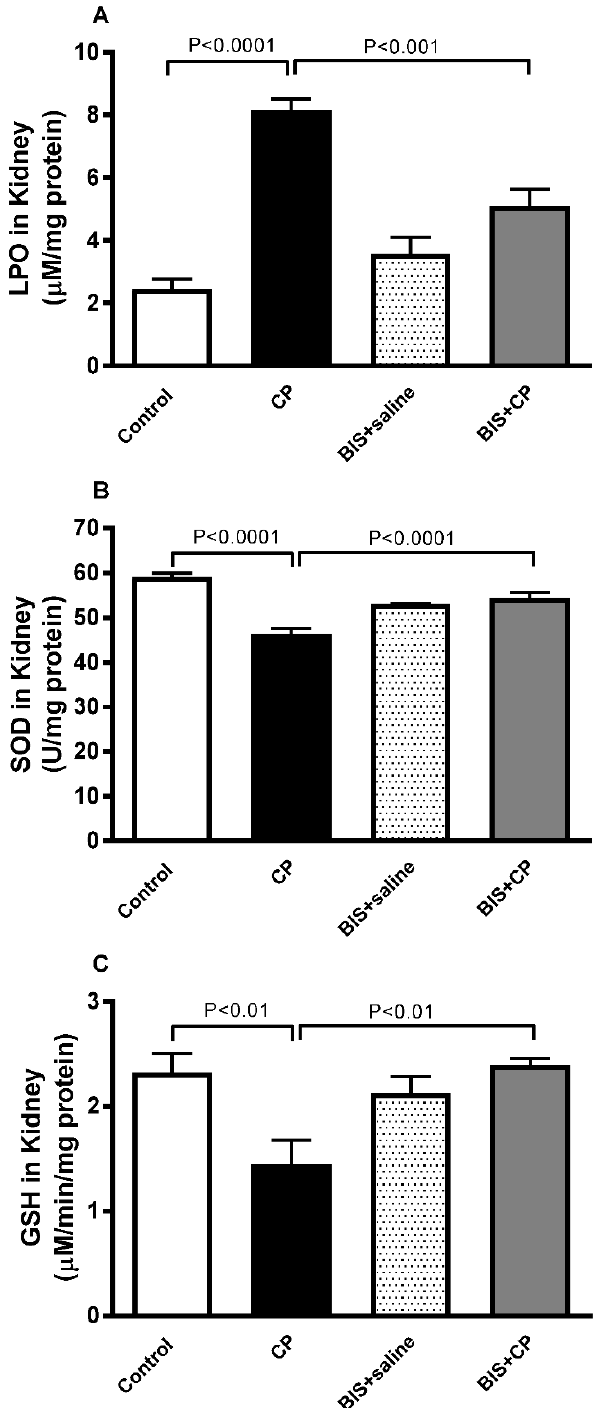
Figure 6. The renal levels of lipid peroxidation (LPO, ( A )), superoxide dismutase (SOD, ( B )), and reduced glutathione (GSH, ( C )) in mice treated orally with either sunflower oil (control) or bisabolol (BIS, 25 mg/kg) with or without cisplatin (CP, 20 mg/kg) given intraperitoneally (n = 8). Mean ± SEM. Statistical analysis by ANOVA 1 followed by Holm–Sidak’s